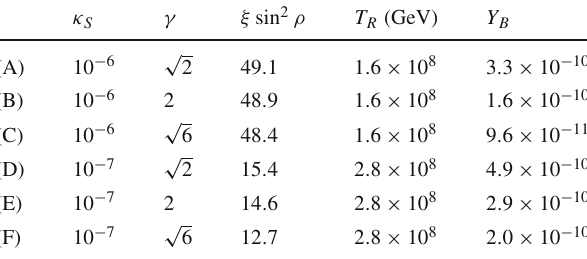
Table 1 Expected values of nonminimal coupling, reheating tempera- ture and baryon number asymmetry generated through leptogenesis. κ S is a value at an intermediate scale w and ξ is estimated at an inflation period by using one-loop RGEs. The condition for the substantial gen- eration of the CP phases in the CKM and PMNS matrices is satisfied for the used